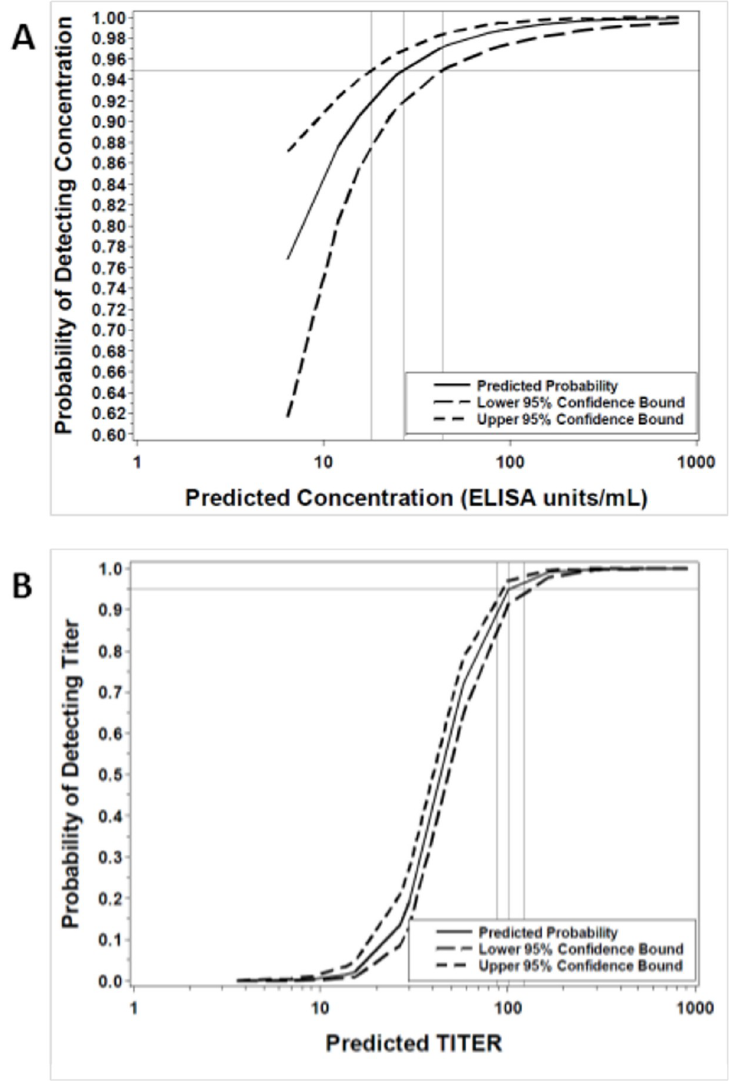
Fig 1. Estimated limits of detection. The logistic curves for the relationship between the probability of detecting the anti-EBOV GP IgG concentration (A) or endpoint titer (B) of a given sample and the predicted log-transformed value are represented by the solid lines, while dotted lines represent the upper and lower 95% confidence bounds for the